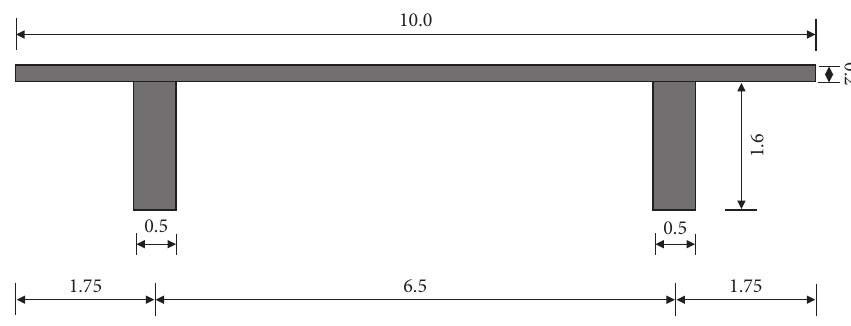
Figure 6: Bridge cross section (dimensions in